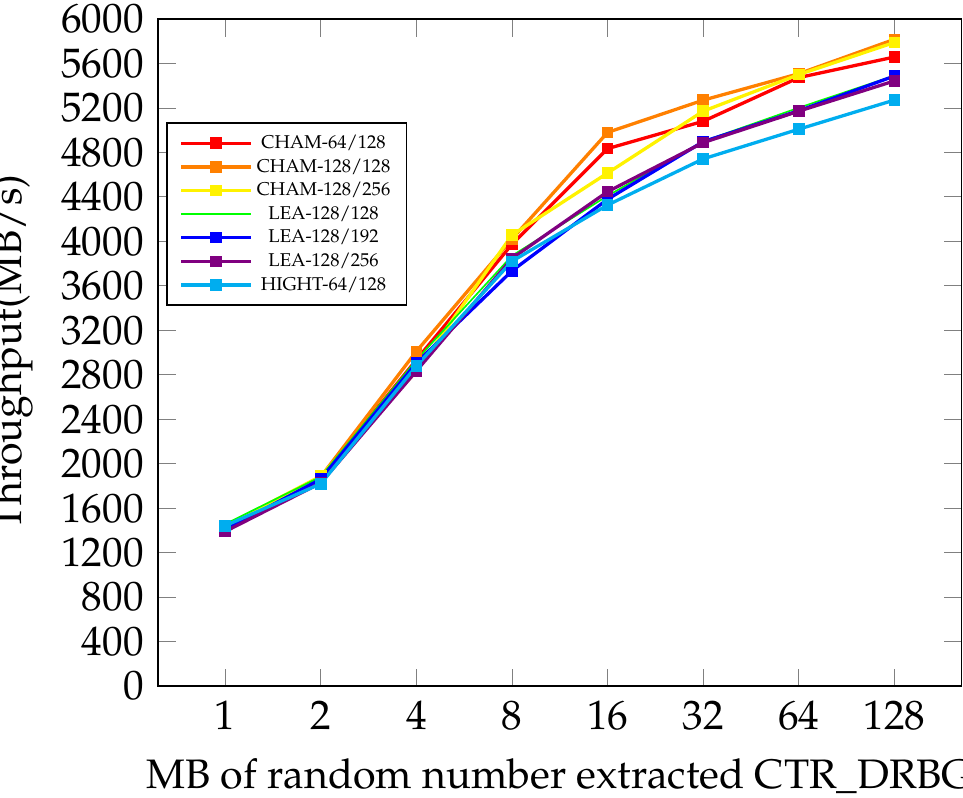
Figure 23. Comparison of throughput (MB/s) for CHAM, LEA, and HIGHT implementations on GPU platform platform. (cipher-n/m means n-bit plaintext encryption with the m-bit